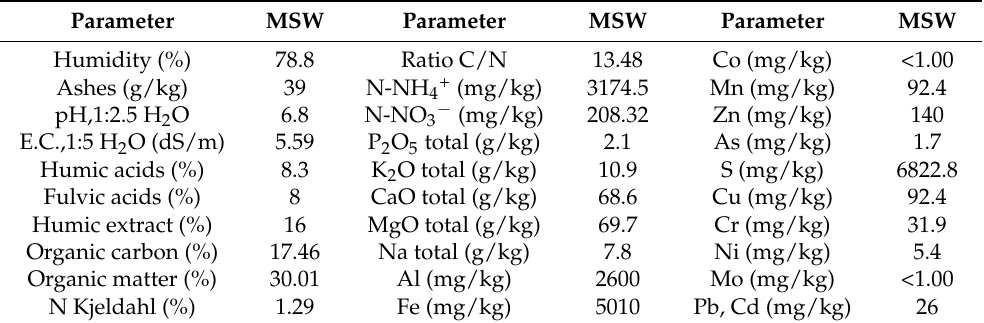
Table 1. Physicochemical properties of the bio-stabilized municipal solid waste amendment (MSW) in dry matter.